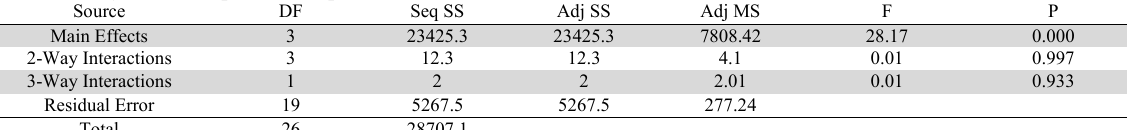
Variance analysis for the producer’s profit Source